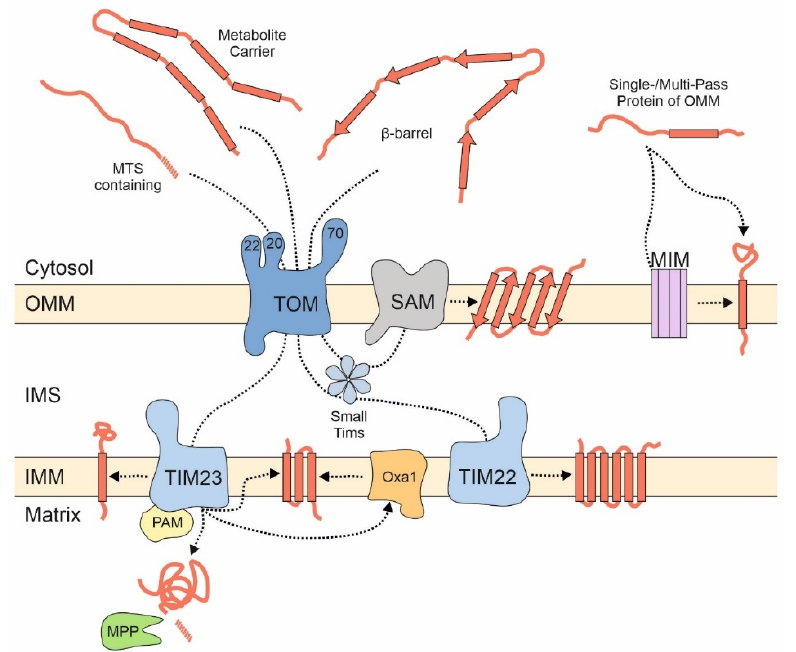
Figure 1. Different groups of mitochondrial proteins embark on different import pathways. Proteins of the matrix and many inner membrane proteins are synthesized as precursor proteins with N-terminal matrix targeting signals (MTSs) and imported via the TOM and TIM23 complexes. The PAM complex serves as motor for their translocation reaction. The mitochondrial processing peptidase (MPP) removes the MTS of most of these proteins. Metabolite carriers lack presequences and are integrated into the inner membrane by the TIM22 complex. The SAM complex integrates β -barrel pro- teins into the outer membrane. Many outer membrane proteins with helical transmembrane domains bypass the TOM complex but can be dependent on the MIM complex. IMM, inner mitochondrial membrane; IMS, intermembrane space; OMM, outer mitochondrial membrane. Carrier proteins (also referred to as the SLC25A or metabolite carrier family) are highly abundant proteins of the mitochondrial inner membrane that mediate the exchange of ATP and metabolites between mitochondria and the cytosol. They usually contain